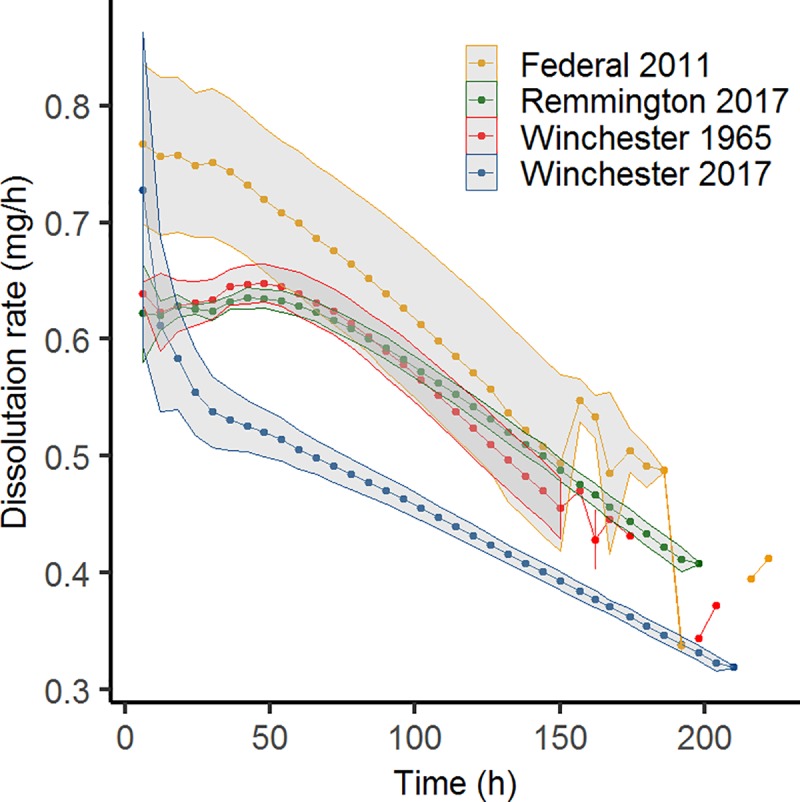
Pellet dissolution rate of the four brand-year types of Pb shot.Shading represents the standard deviation of the replicate samples (n = 6 for Federal shot, n = 3 for all other shot types).